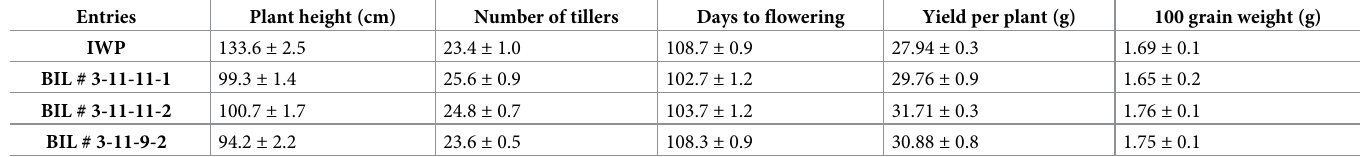
Table 4. Agronomic performance of BILs under field conditions. Entries